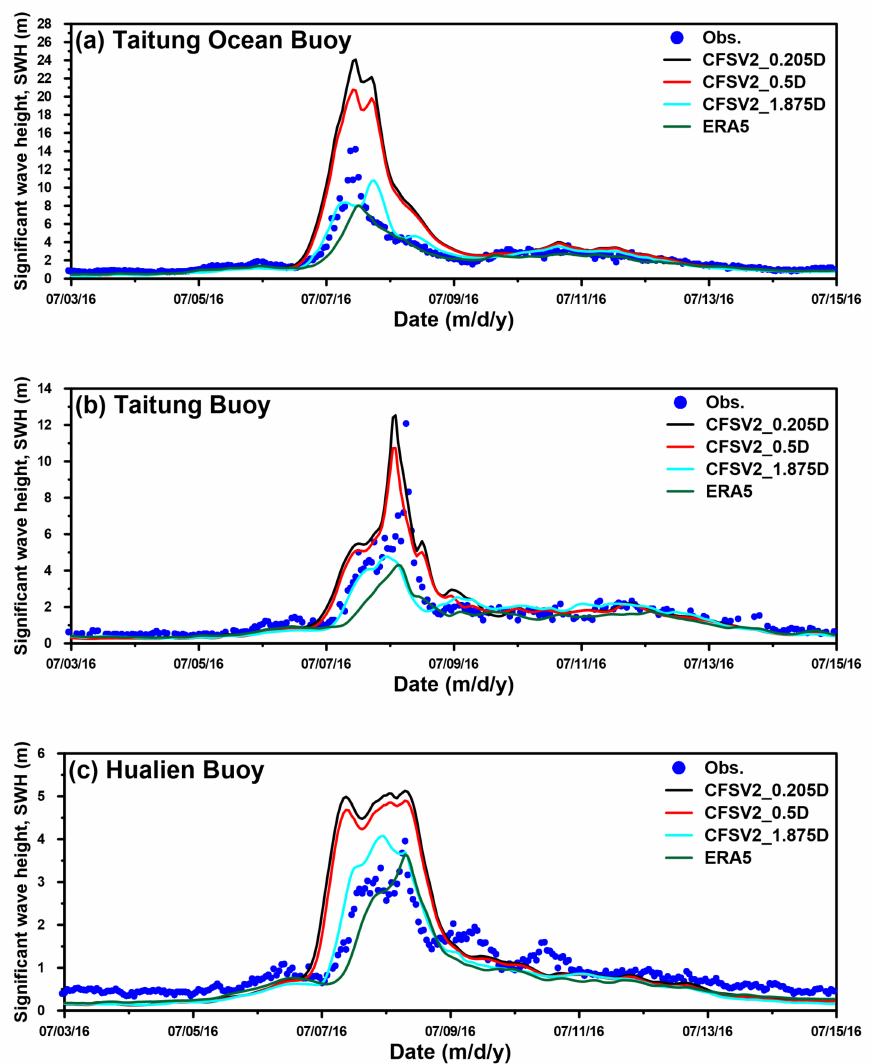
Figure 5. Model-data comparison for SWH time series at the ( a ) Taitung Ocean, ( b ) Taitung, and ( c ) Hualien buoys employing the winds from the hourly CFSV2 at di ff erent spatial